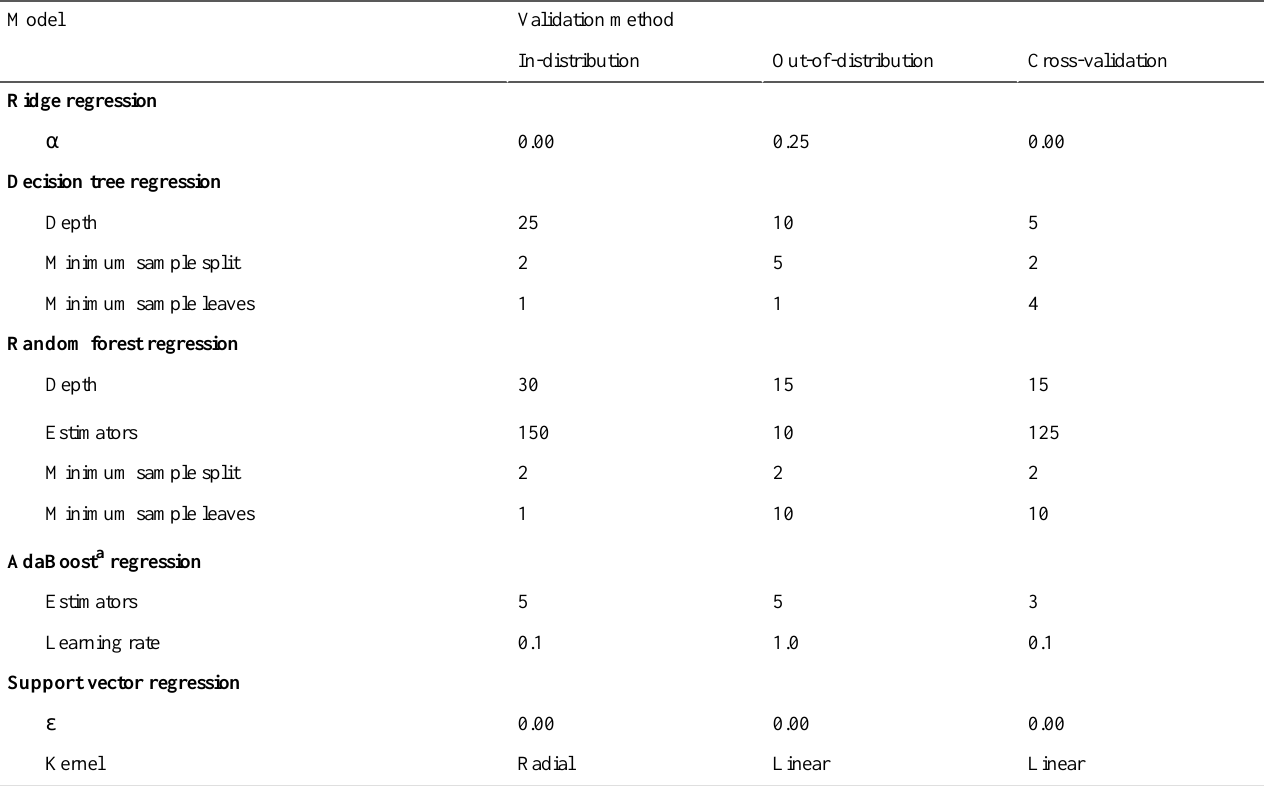
Table 4. Hyperparameters of the optimal configuration (lowest validation mean absolute error) for each model for each validation method. Validation